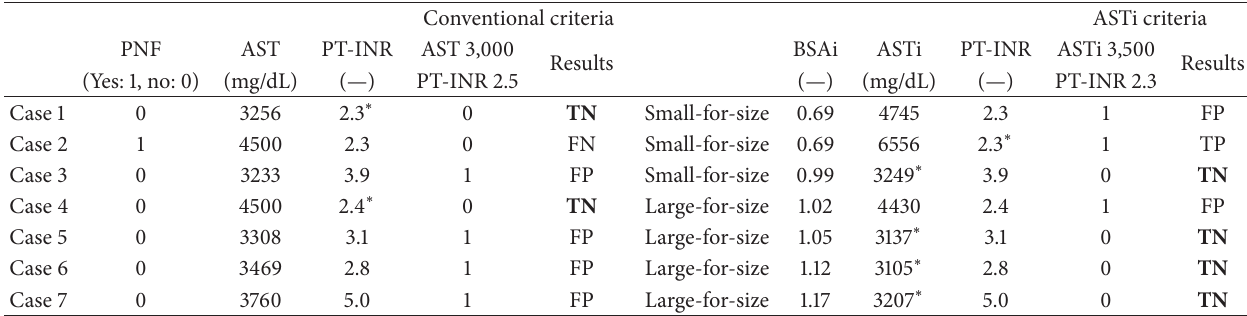
Results for prediction of PNF by two different prediction criteria . Bold font shows the favorable results compared to results of the other criteria. ∗ In PT-INR or AST, ASTi represent the factors, which were responsible for improvement in results. First three cases had small-for-size donors and last four cases had large- for-size donors. AST: aspartate aminotransferase, BSAi: body surface area index, FN: false negative, FP: false positive, PNF: primary nonfunction of graft, PT- INR: international normalized ratio of prothrombin time, TN: true negative, and TP: true